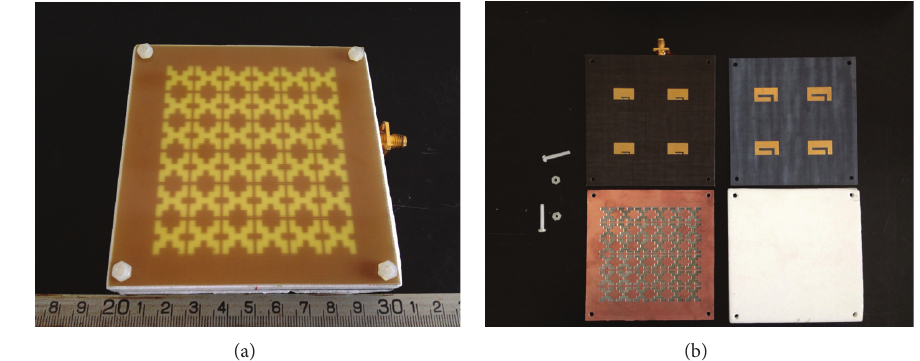
Figure 2: The designed array antenna. (a) Whole profile. (b) Each layer show.